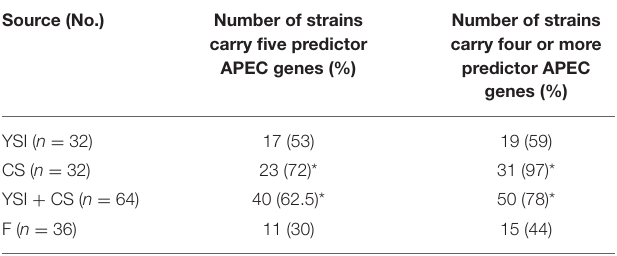
and A had the highest and lowest VAG scores, respectively TABLE 2 | Frequency of predictor APEC virulence genes ( iss, iutA, hly, iroN , and ( p < 0.05). Distribution of VAGs among colisepticemic E. ompT ) among yolk sac infection, colisepticemia, and fecal Escherichia coli strains. Number of strains Source (No.) carry four or more APEC genes (%)